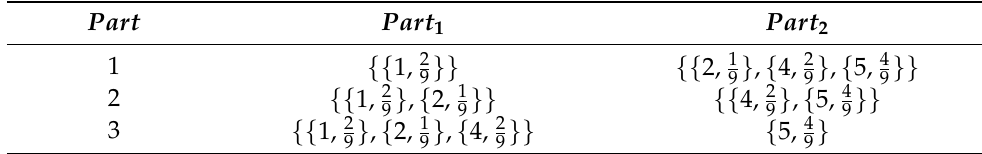
Table 3. Partitions obtained for the histogram e .